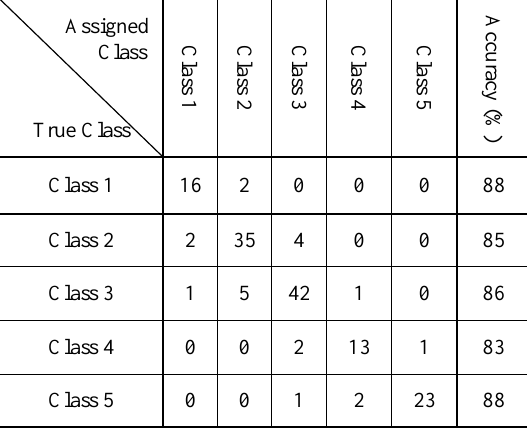
Table 6. Accuracy of classification per class